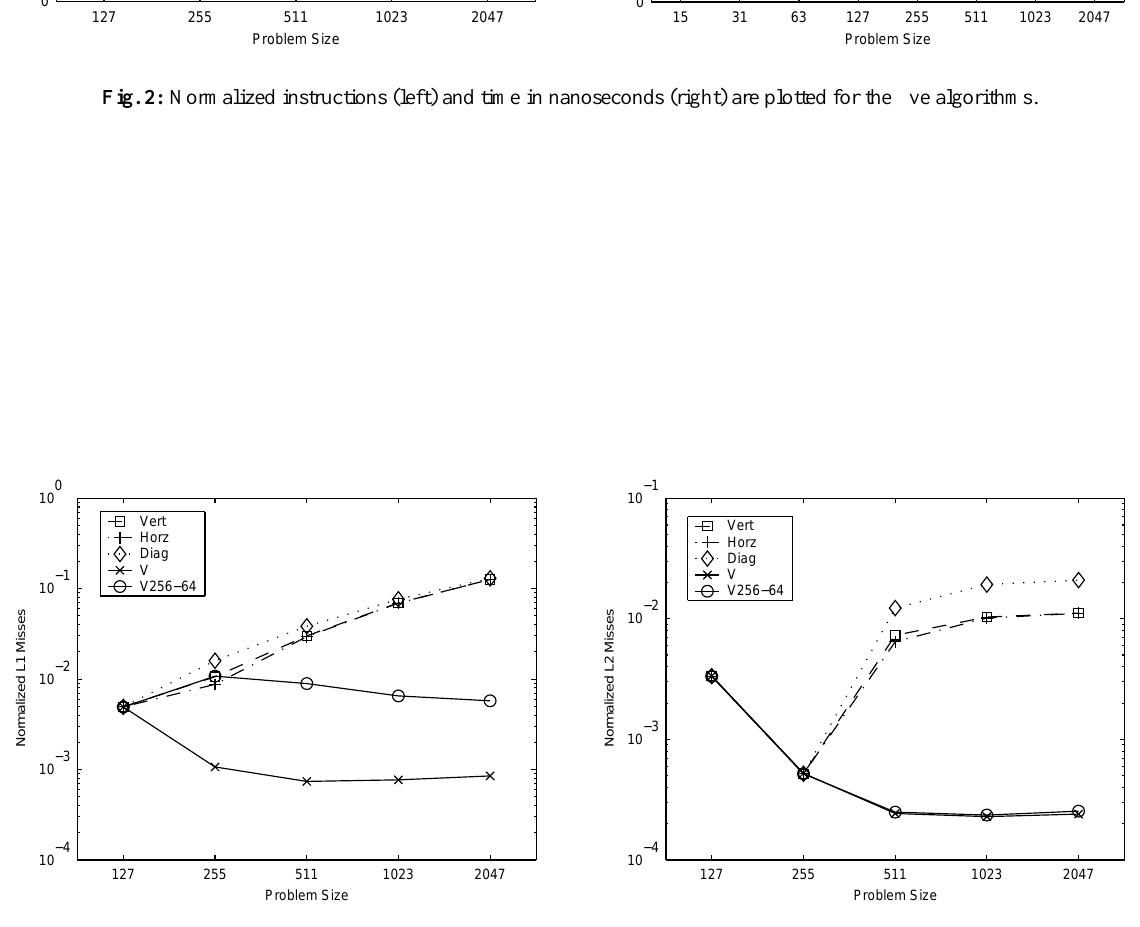
Fig. 3: Normalized cache misses for L1 (left) and L2 (right) are plotted for the five